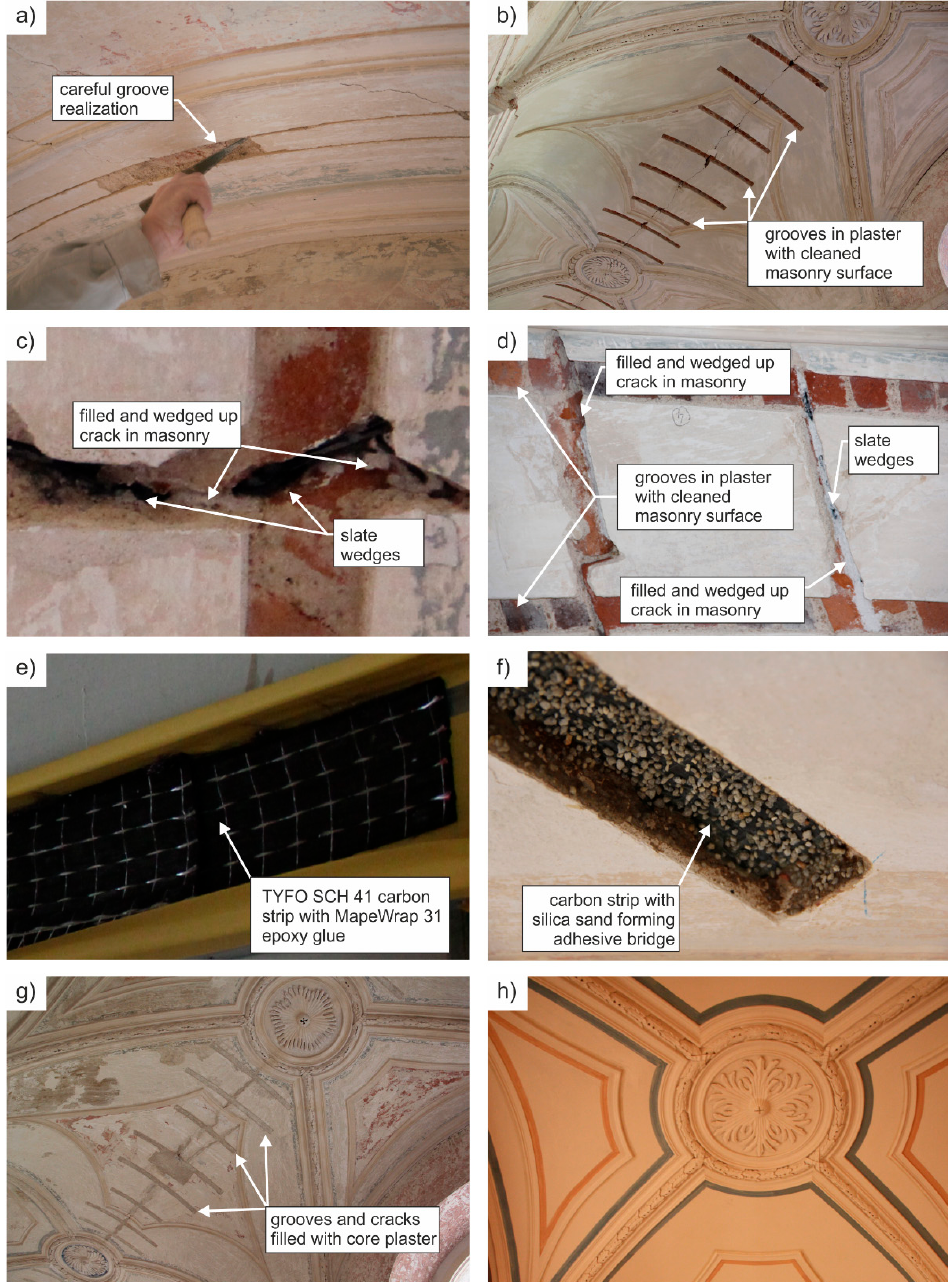
Figure 8. The procedure for implementing the reinforcing strips on damaged vaults over 1st OS: ( a ) groove cut in plasters; ( b ) prepared grooves in the vault soffit; ( c ) wedging of cracks greater than 3 mm with slate wedges; ( d ) closing cracks and subsequent grouting of wedged cracks with lime mortar of adequate consistency; ( e ) preparation of carbon strips 45 mm in width using the TYFO SCH 41 carbon fiber sheet of medium thickness saturated with the MapeWrap 31 two-component epoxy resin; ( f ) application of silica sand with a grain size of up to 4 mm into non-hardened epoxy resin on the exterior surface of carbon strips to ensure good strip-plaster adhesion; ( g ) grooves filled with core